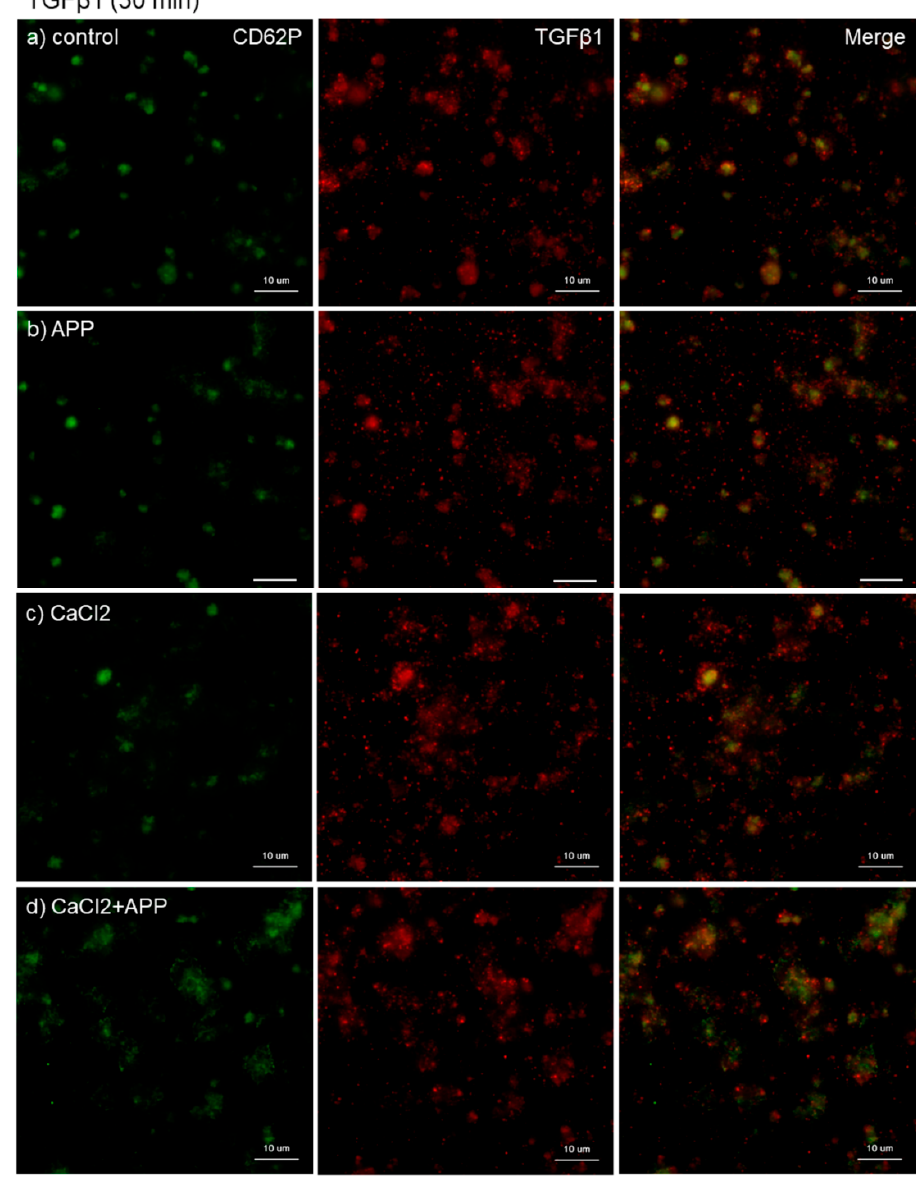
Figure 7. Effects of CaCl 2 , and APP treatments on TGF β 1 distribution on cp-Ti plates at 30 min. Platelets were prepared, treated, and fixed for visualization (green: CD62P, red: TGF β 1) as described in the legend of Figure 4. ( a ) Control platelets on non-treated cp-Ti plates, ( b ) control platelets on APP-treated cp-Ti plates, ( c ) CaCl 2 -stimulated platelets on non-treated cp-Ti plates, ( d ) CaCl 2 -stimulated platelets on APP-treated cp-Ti plates. Similar findings were obtained from the samples prepared from the other three donors. Bar = 10 µ